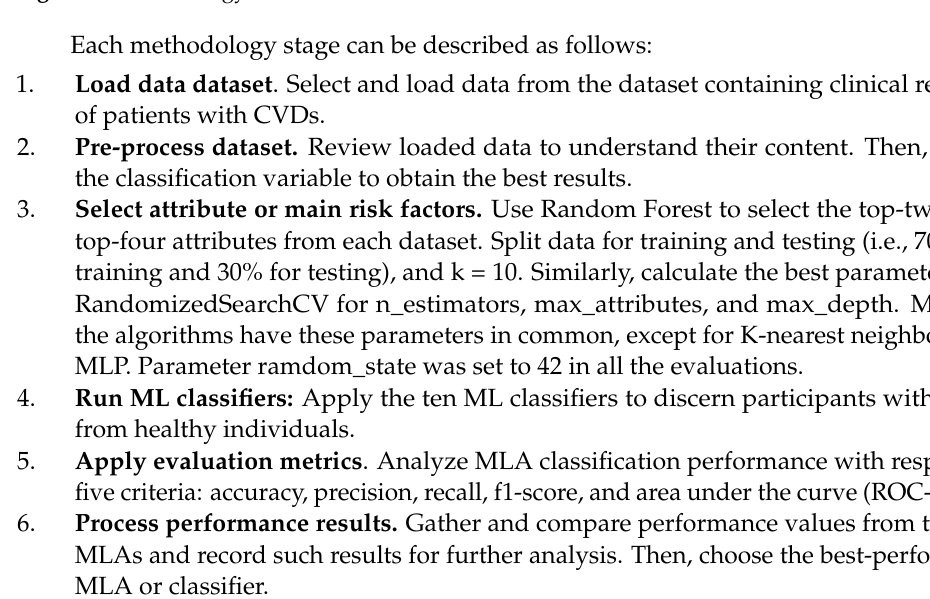
Figure 1. Methodology for the evaluation of CVD datasets.